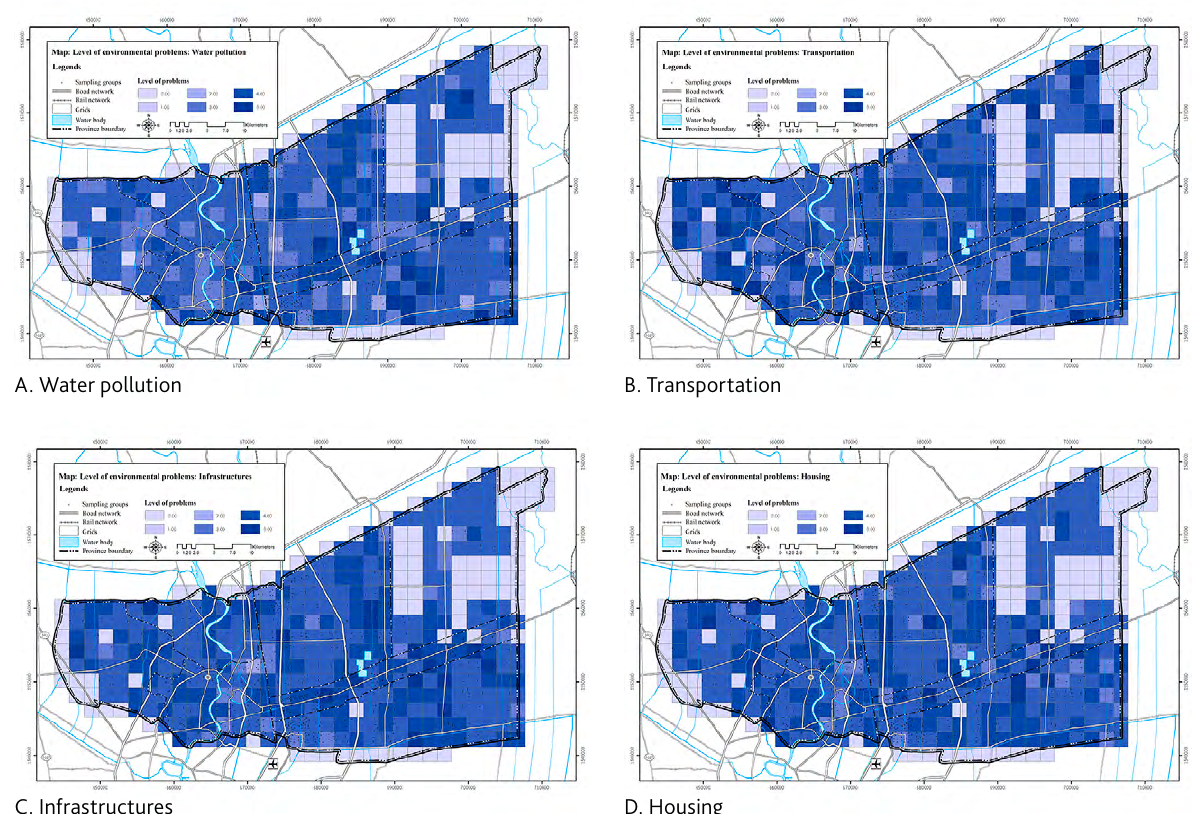
Figure 4. Average score of different built environment factor (continued on next